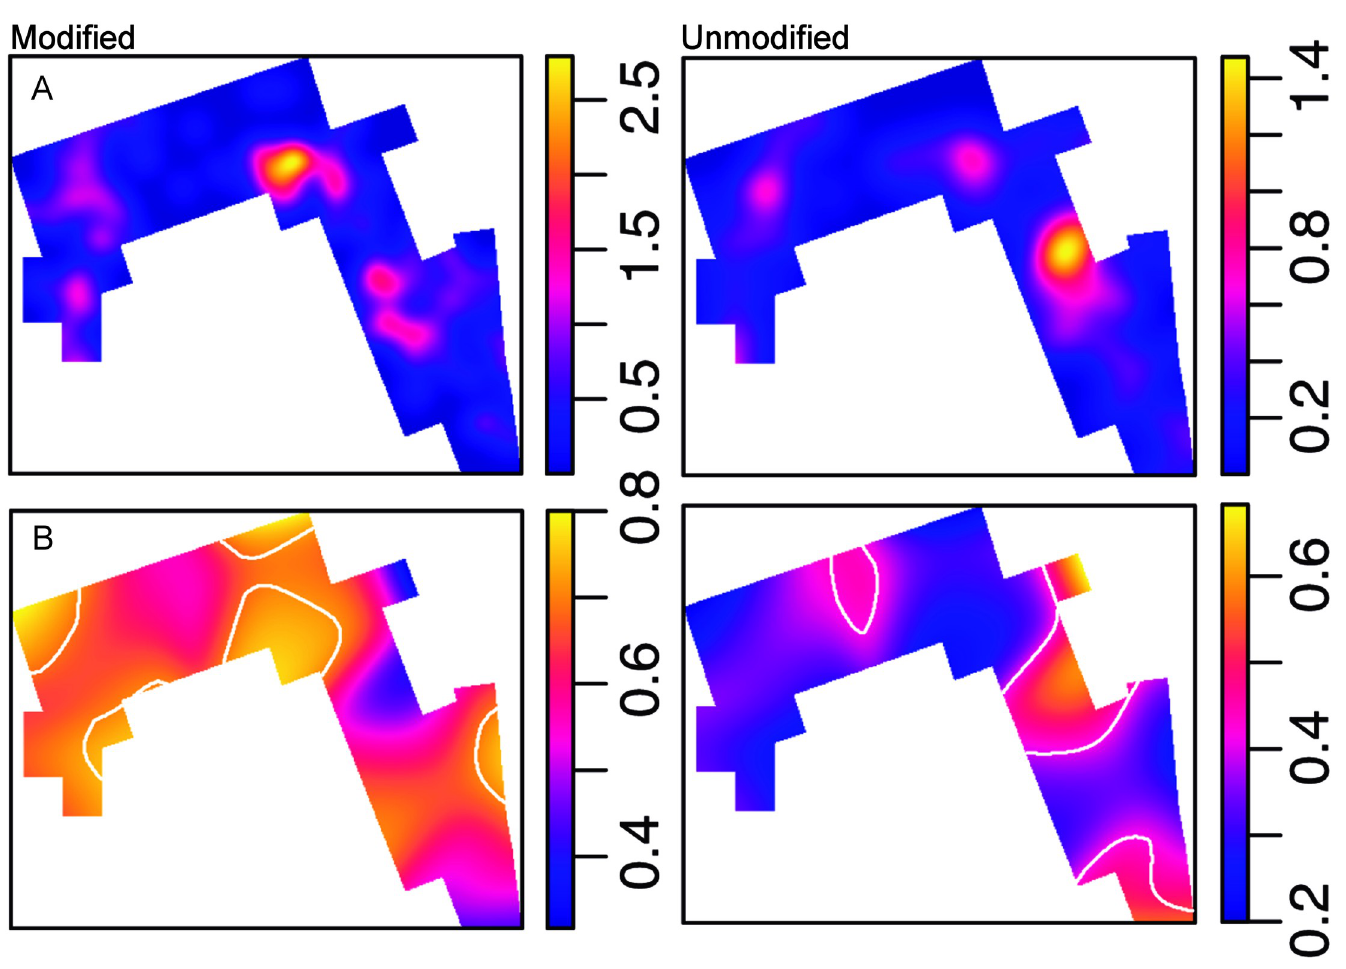
Fig 10. Distribution of modified and unmodified materials. A. Density maps. B. Spatial probability (relative-risk) maps. Tolerance contours (white) show areas of significant deviation from the average proportion between modified and unmodified materials.